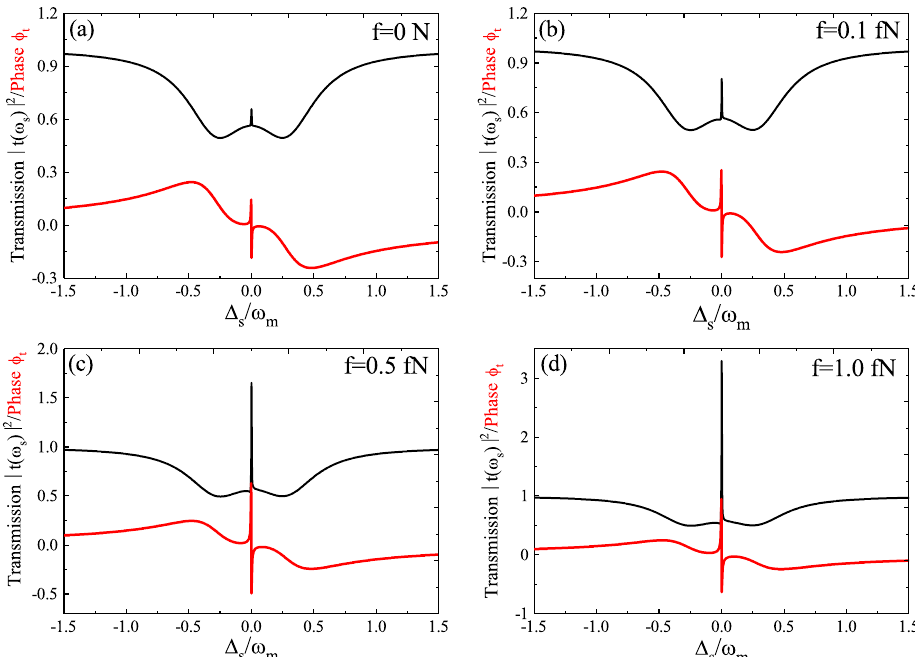
Figure 2. The transmission T (black curve) and phase φ t (red curve) of the probe light as a function of ∆ s for four different driving amplitude f : ( a ) f = 0; ( b ) f = 0.1 fN; ( c ) f = 0.5 fN; ( d ) f = 1.0 fN. The other parameters are J = 1.0 κ c , ϕ m = π /2, P = 5 µ W, and ∆ c = ∆ a = ω m